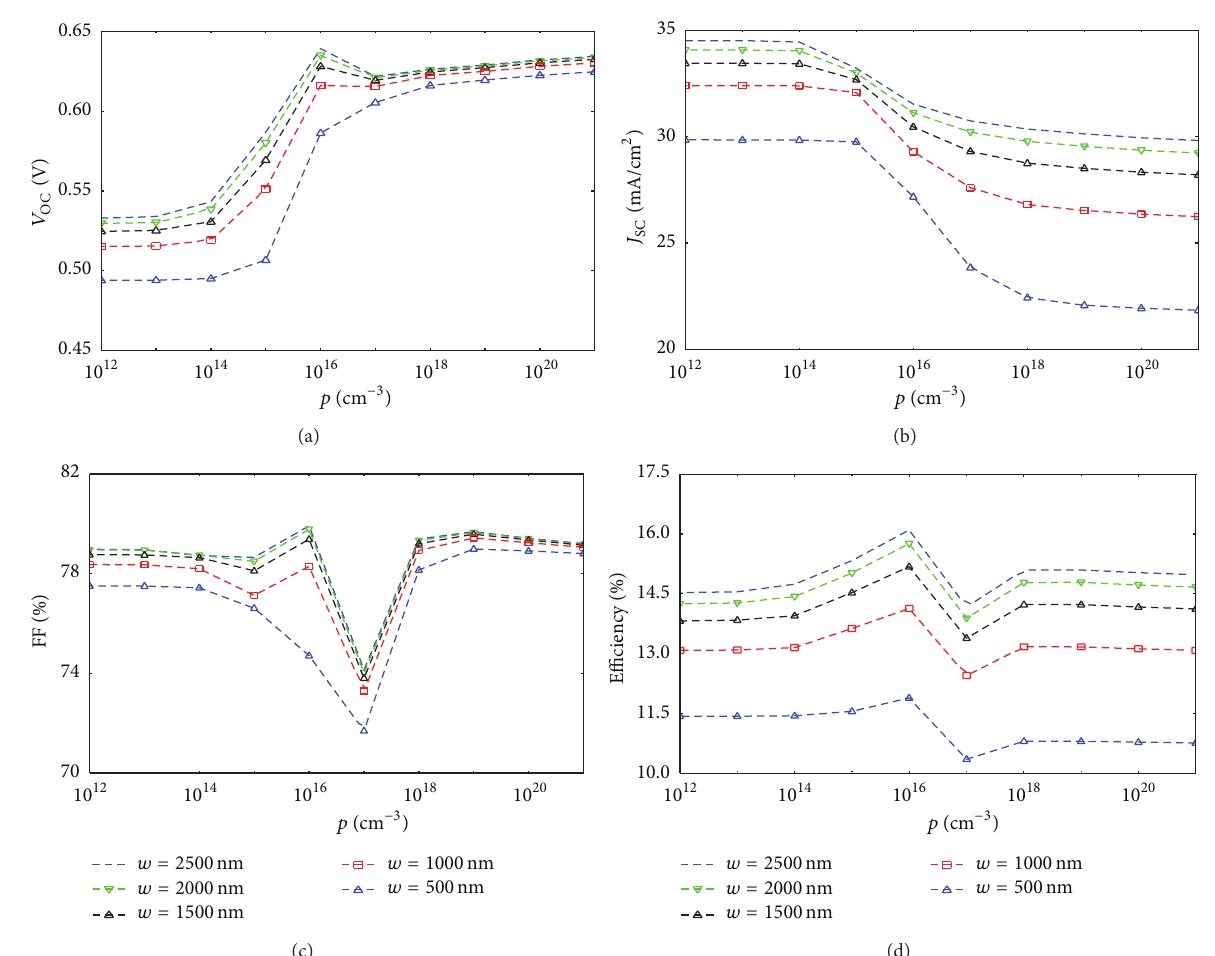
Figure 5: The simulated performance of hole density on 𝑉